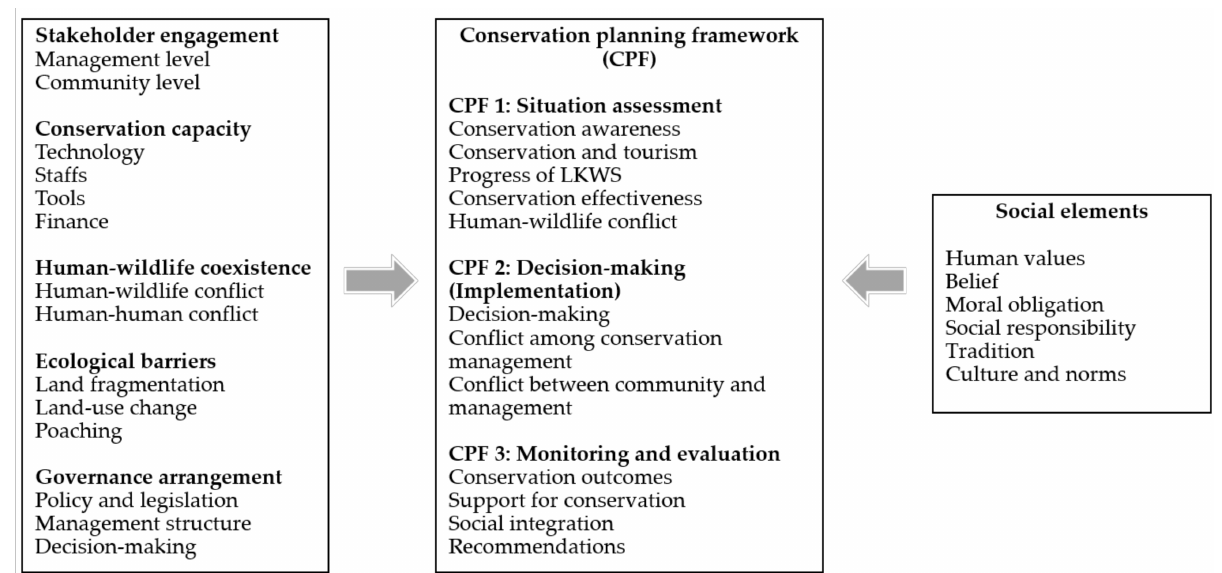
Figure 1. Conceptual framework of conservation planning in Kinabatangan.